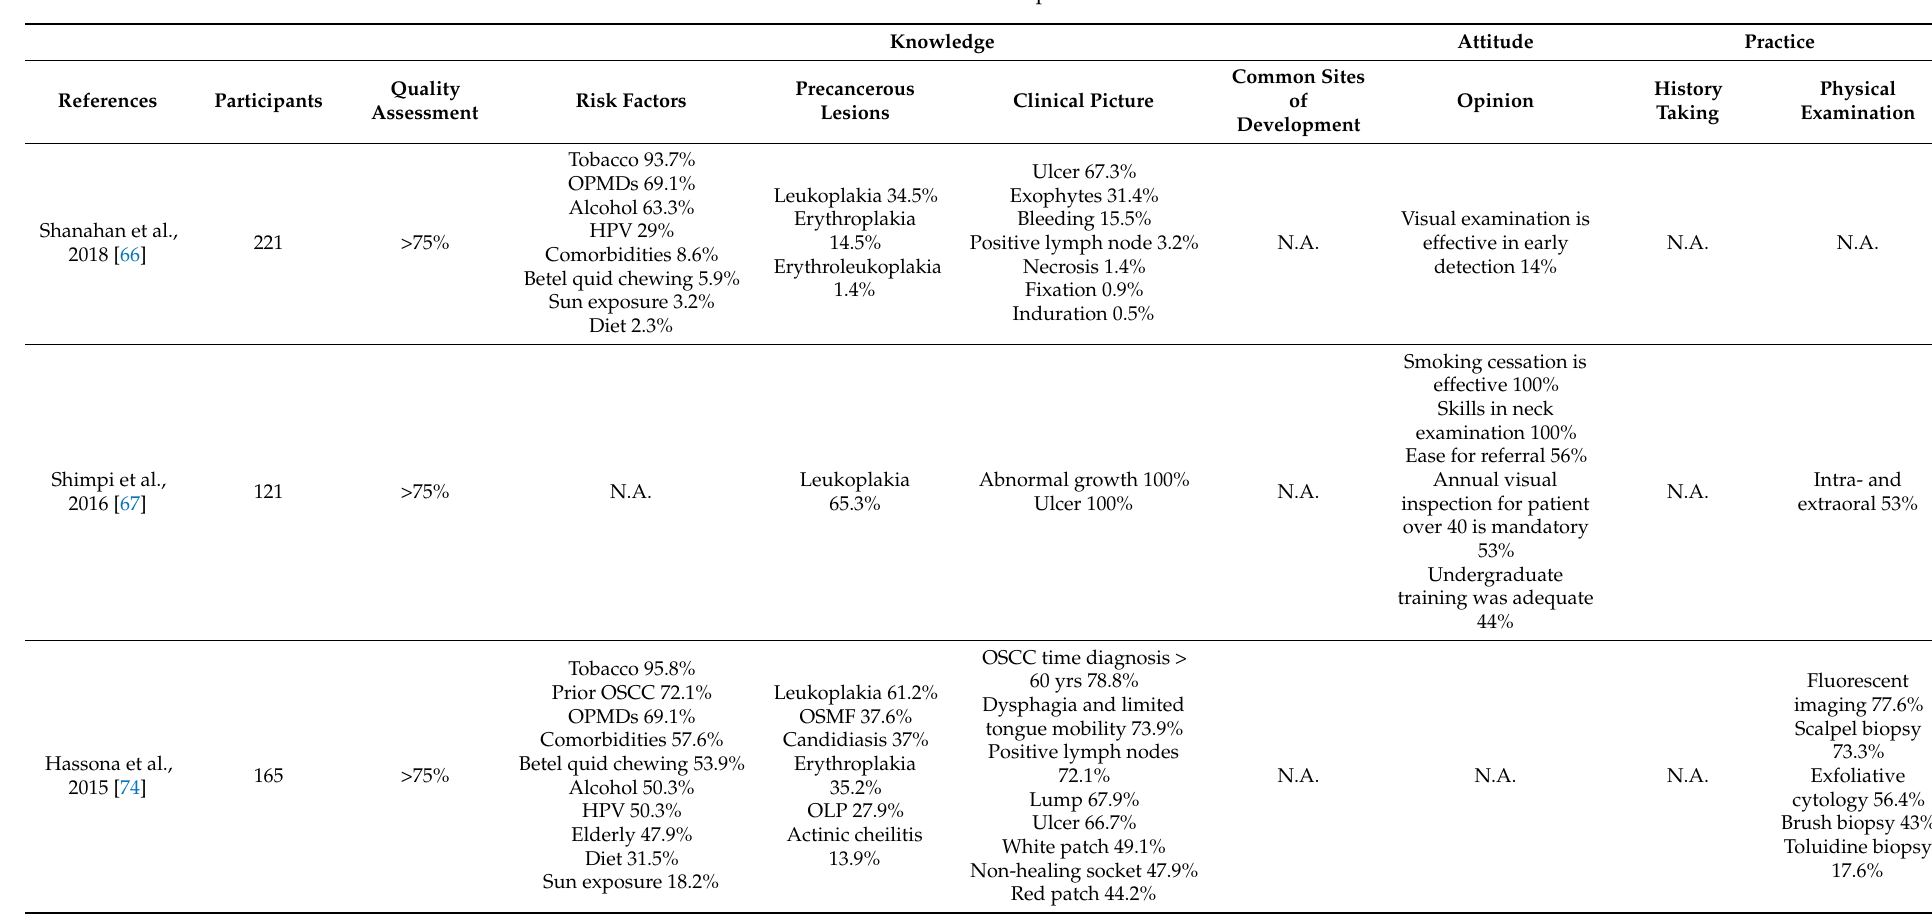
Table 4. Published data about medical practitioners’ KAP on